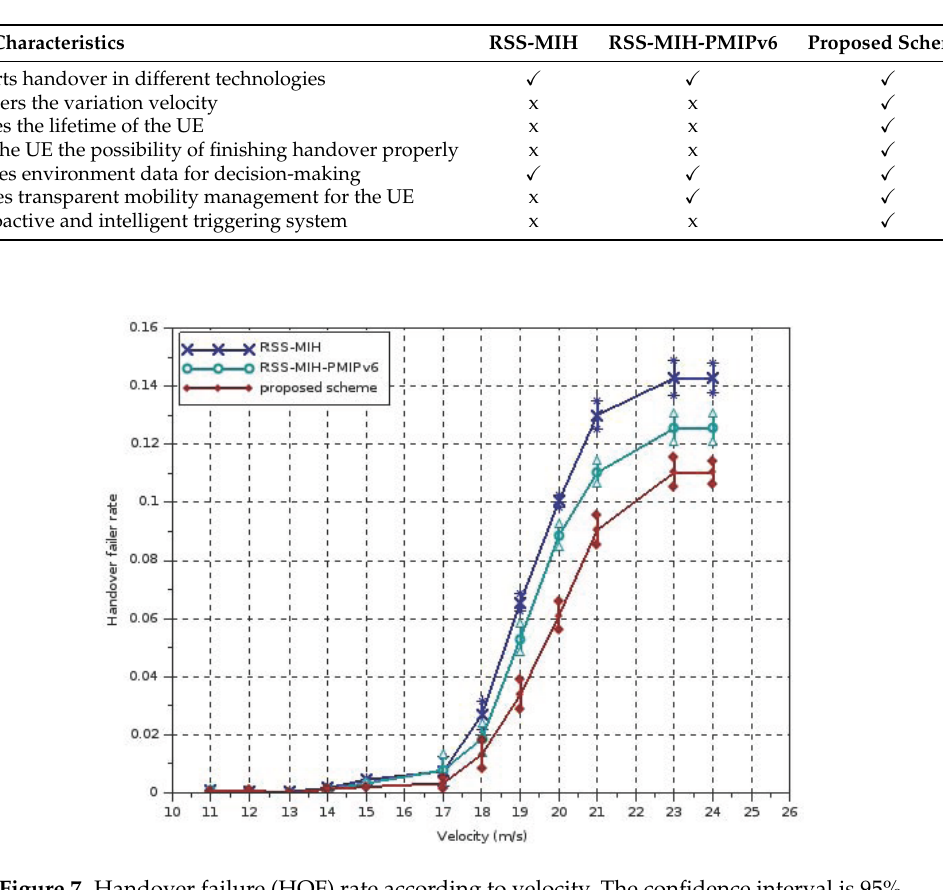
Table 2. Main features of the studied schemes.